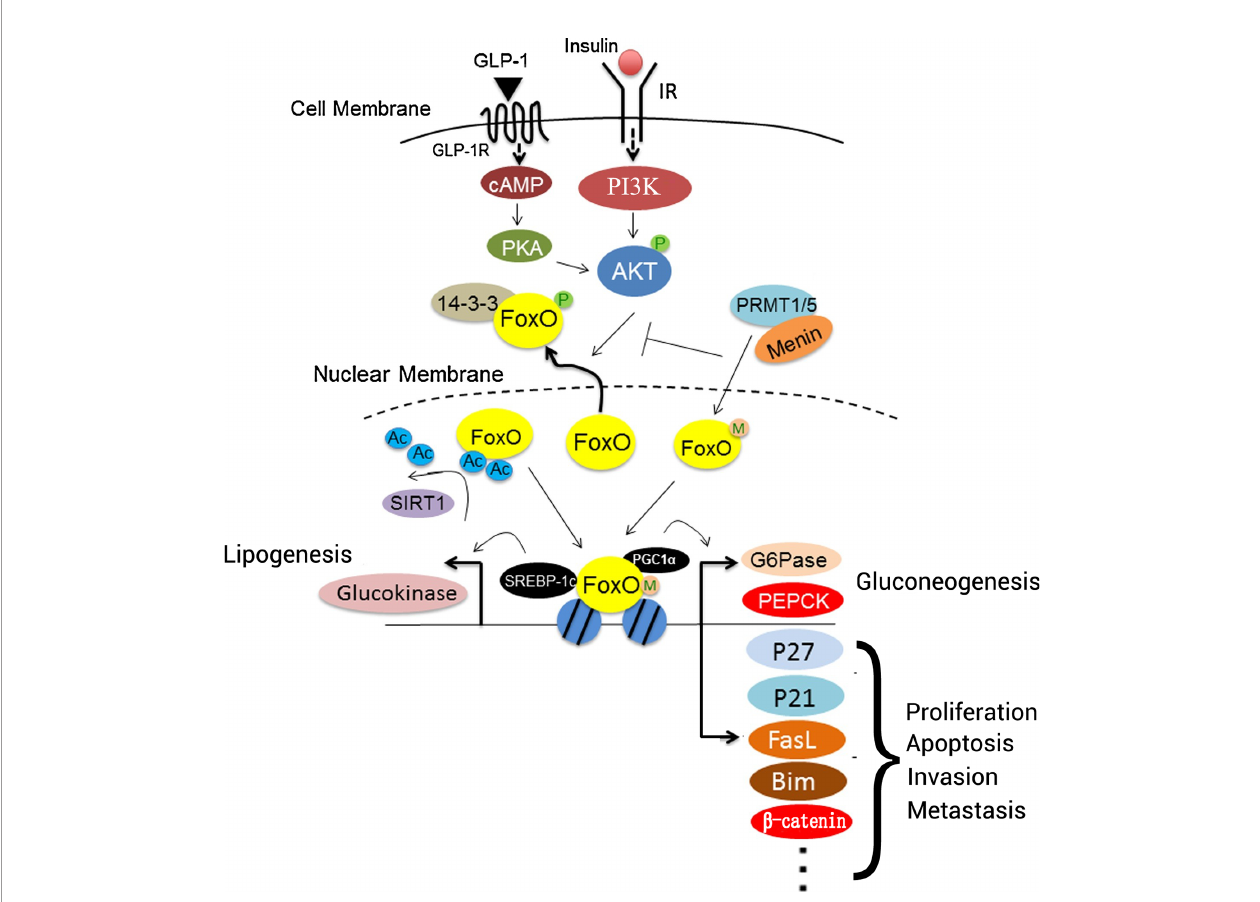
FIGURE 3 | Roles of FOXO proteins in liver cells. Insulin or GLP-1 treatment can activate both PI3K/AKT and PKA. FOXO proteins interact with PGC1 a to regulate the expression of gluconeogenesis-associated genes, including G6Pase and PEPCK, to promote gluconeogenesis. In addition, FOXO proteins interact with P27, P21, FasL, BIM, and b -catenin to regulate cell proliferation, apoptosis, invasion, and metastasis. SIRT1 deacetylates FOXO proteins after binding, which promotes their transcriptional activity. Menin may recruit PRMT1 or PRMT5 to methylate FOXO proteins, and it sterically hinders the phosphorylation of FOXO proteins by protein kinases. Additionally, FOXO proteins interact with SREBP-1c to activate the transcription of lipogenesis-associated genes involved in lipid metabolism, such as glucokinase. IR, insulin receptor; FasL, Fas ligand; FOXO, forkhead box O protein; GLP-1, glucagon-like peptide-1; GLP-1R, glucagon-like peptide-1 receptor; PEPCK, phosphoenolpyruvate carboxykinase; PGC1 a , PRMT1, protein arginine methyltransferase 1; SIRT1, sirtuin 1; SREBP-1c, sterol regulatory element-binding protein 1; G6Pase, G6P-phosphatase; Ac, acetylation; PGC1 a , peroxisome proliferator-activated receptor g coactivator 1 a ; M, menin; P, phosphorylation.